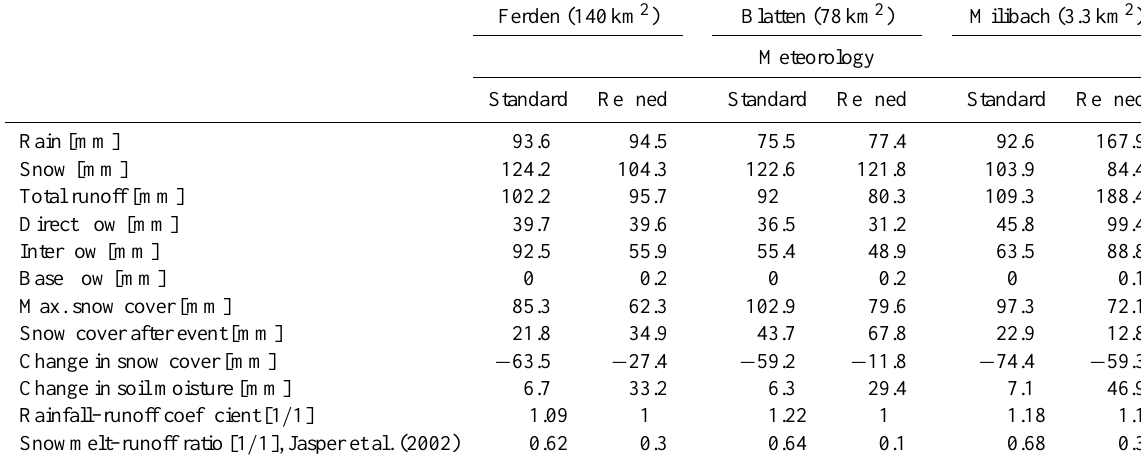
Table 3. Water fluxes, storages and characteristic values during the peak flow from 6 to 10 October 2011 for SM2 melt modules under standard and refined meteorology and parameters.